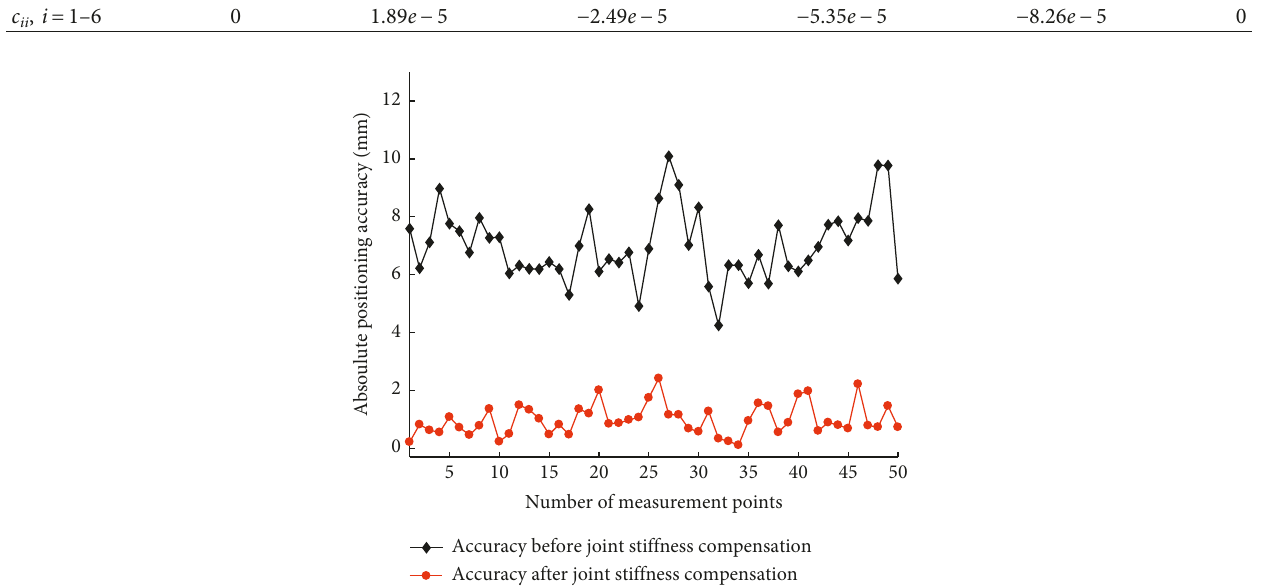
Figure 6: Positioning accuracy after the calibration of stiffness parameters under the full load condition. Table 7: Absolute positioning accuracy of the SIASUN SR210D manipulator.